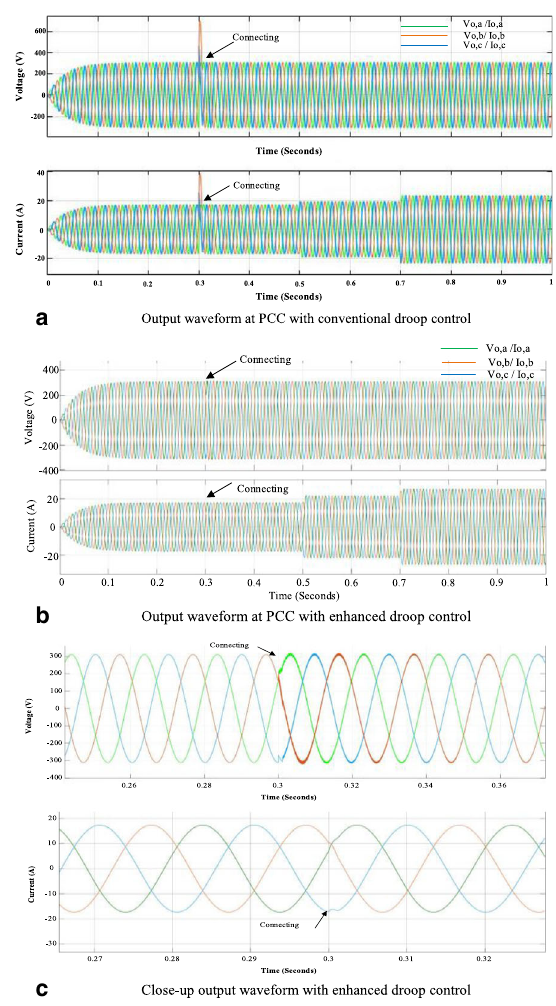
Fig. 8 Output voltage and current waveforms at PCC under the proposed dual -control